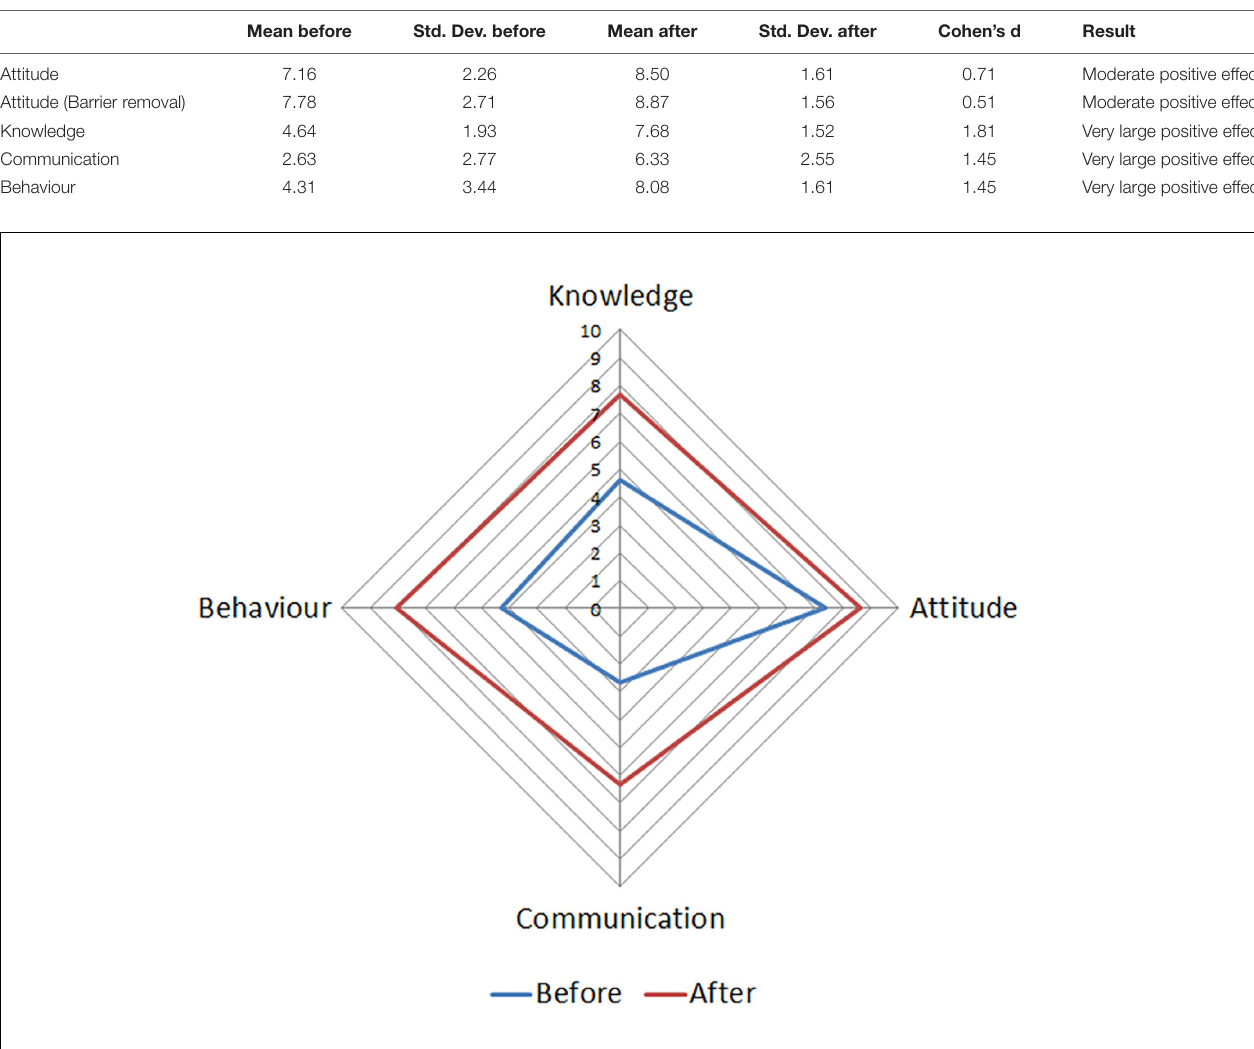
TABLE 5 | Measuring effect size of pre- and post-survey scaled question results using Cohen’s d. Mean before Std. Dev. before Mean after Std. Dev. after Cohen’s d